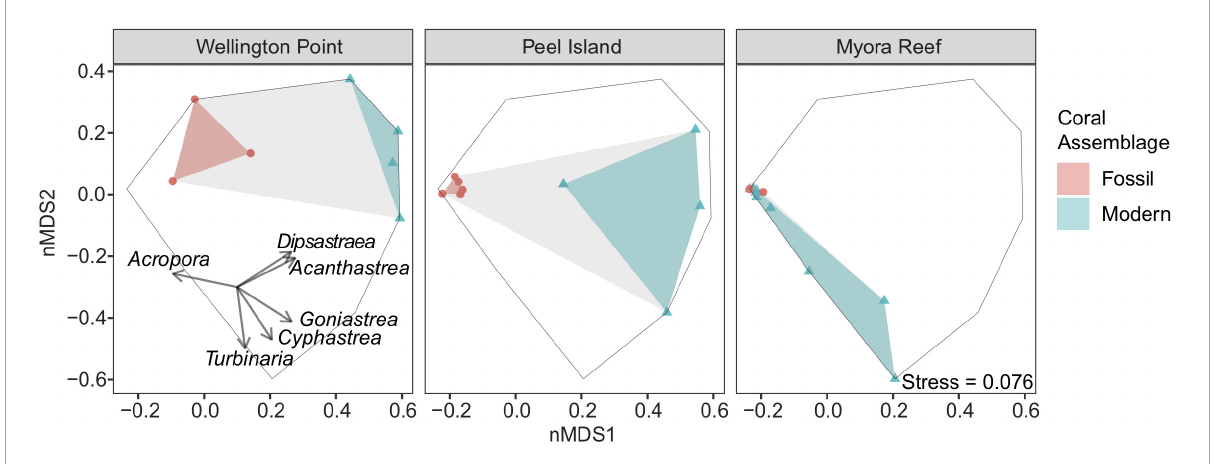
FIGURE6 Non-metric multi-dimensional scaling (nMDS) ordinations of community composition among modern and fossil coral assemblages from all three sites using relative abundance data, to infer historical variation for reefs in Moreton Bay. Each symbol represents either the modern or fossil assemblage per site. Overlaid vectors are the weighted contribution of each genera’s relative abundance and are only shown for the genera with a significant contribution ( p < 0.05) to the dissimilarities between fossil and modern assemblages among sites. Black outline represents total hull space. Gray shading represents total hull volume for both the fossil and modern coral assemblages per site.